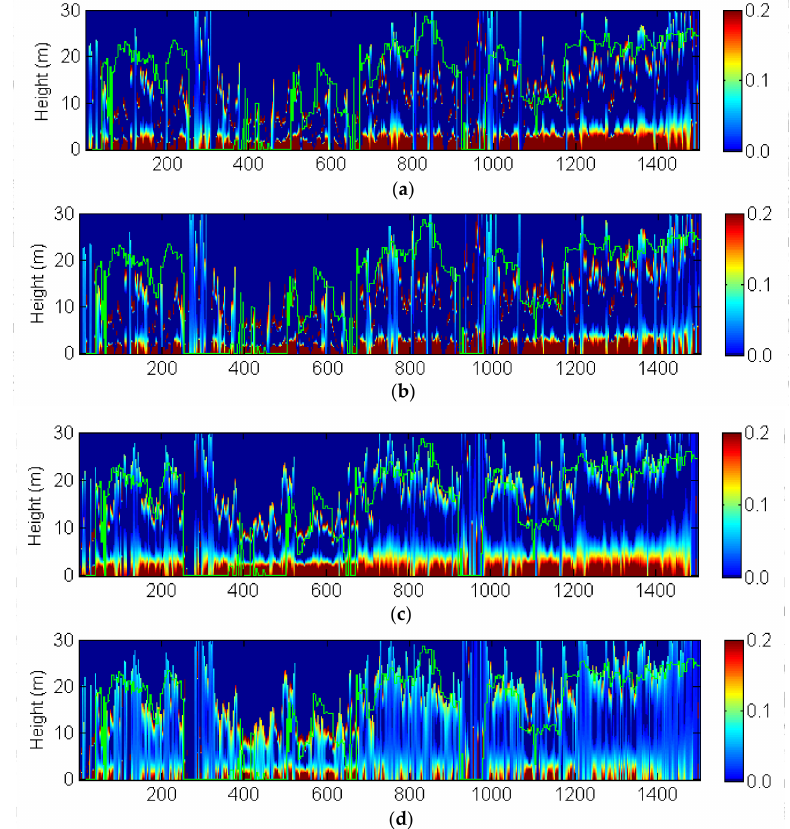
Figure 5. Tomographic profiles for different polarimetric channels along the range direction in the line 2500, see the yellow dashed line in Figure 1. ( a ) HH-VV channel; ( b ) HV channel; ( c ) PD low channel; ( d ) PD high channel. The green lines denote the LiDAR height. PD: phase